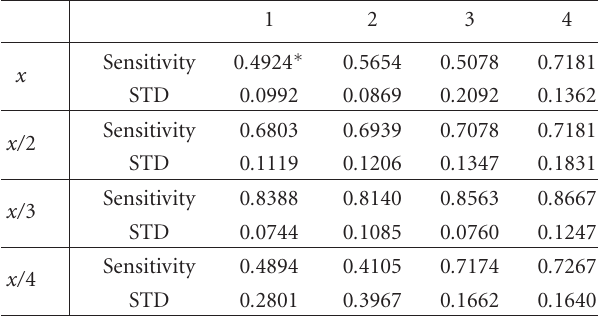
Table 2: Four-fold cross-validation results to determine the opti- mum threshold value (STD—standard deviation). Mean sensitivi- ties towards identifying a positive interaction derived from 16 test- ing images: 0 . 57 when using the threshold value ( x ) from Otsu’s method; 0 . 7 when using x/ 2 as the threshold; 0 . 84 when using x/ 3 as the threshold, and 0 . 58 for a threshold of x/